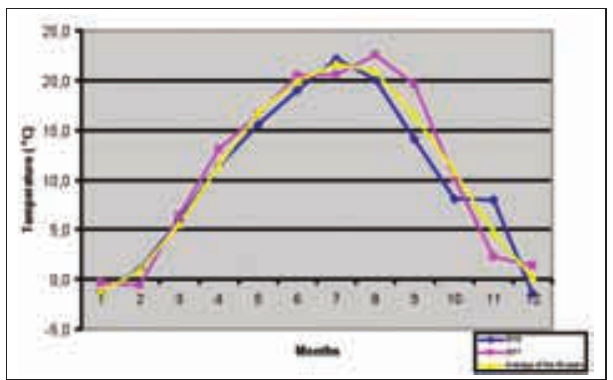
Figure 1a: Monthly average temperatures in 2010 and in 2011, compared with the average of 49 previous years